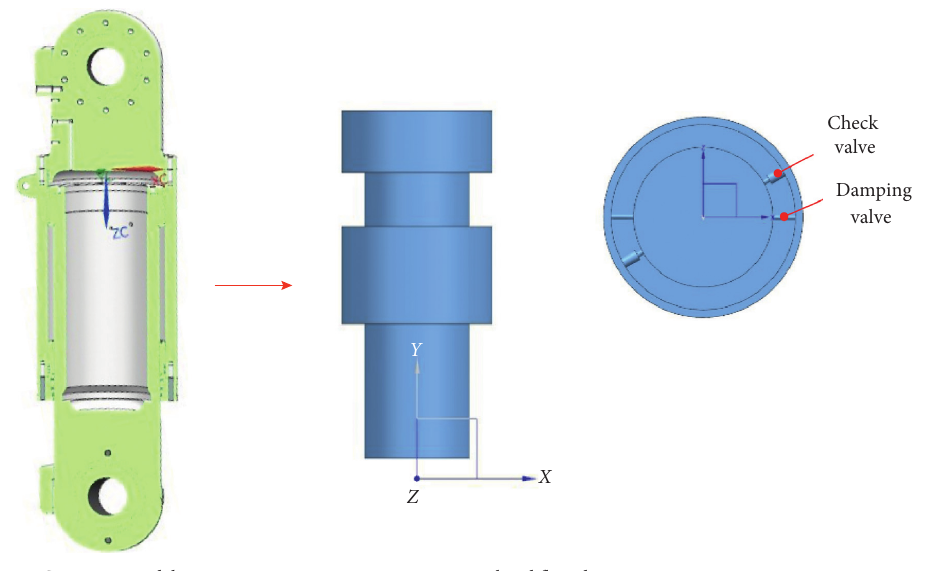
Figure 3: 3D model and isolated flow domain of the HPS.